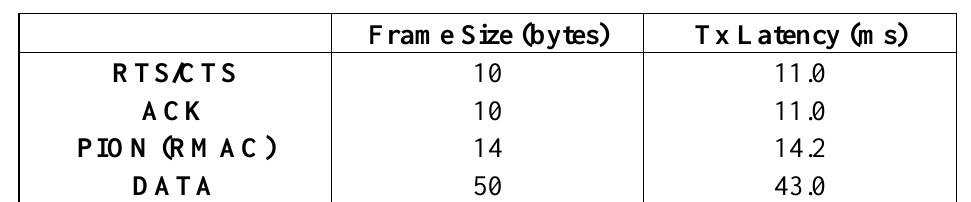
Table 2. Transmission Duration